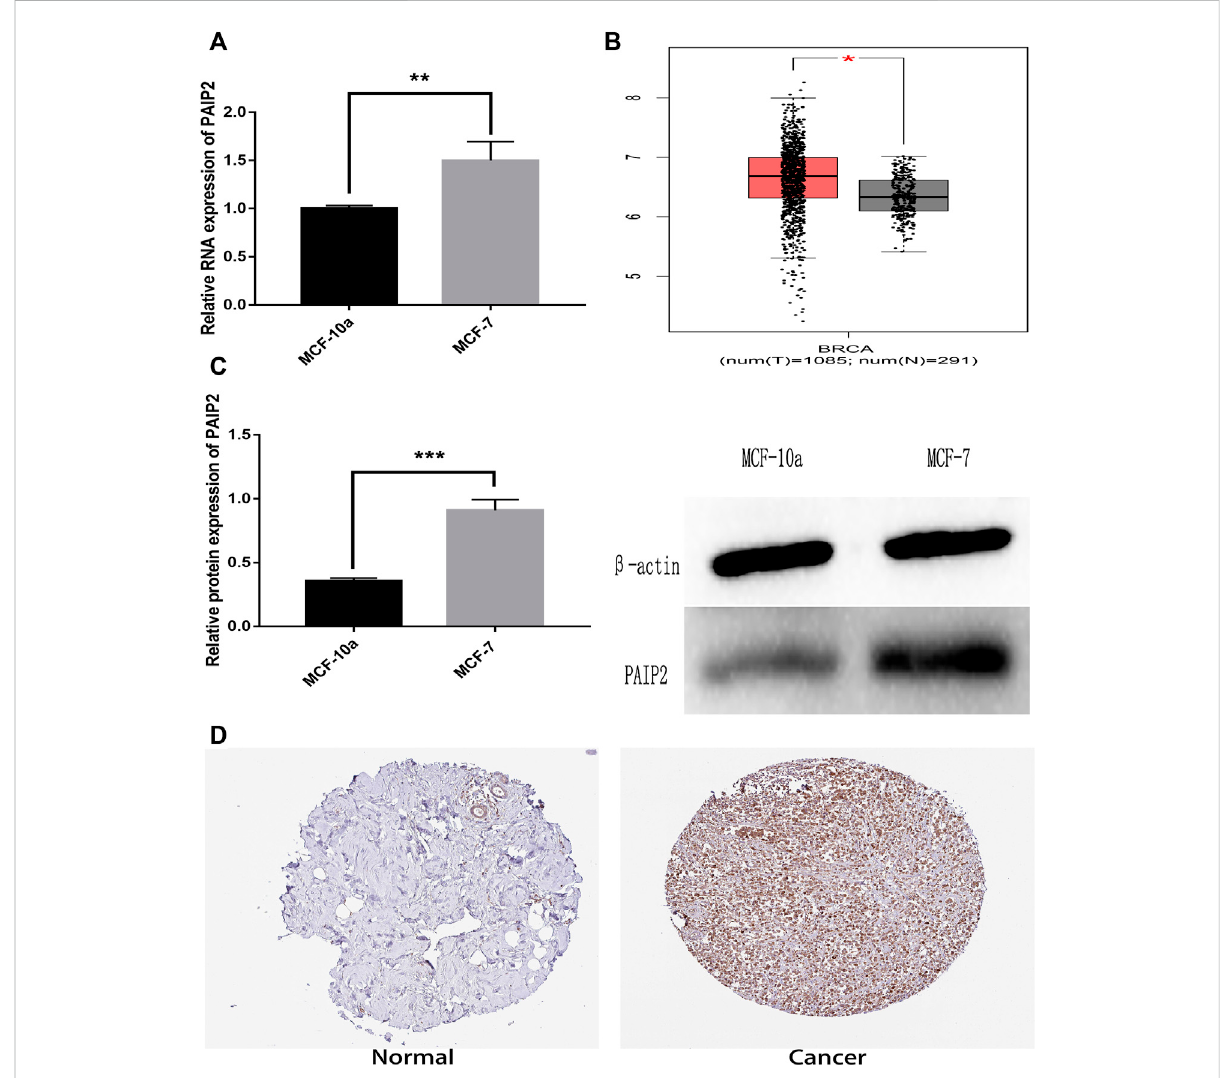
FIGURE 1 RelativeexpressionofPAIP2inbreastcancerspecimensandbreastcancercells. (A) :RT-qPCRshowedarelativelyhigherexpressionofPAIP2at mRNAlevelinbreastcancercells. (B) :ThePAIP2expressionofBRCAtissuesamplesinTCGAdatabasewashigherthanthatofbreastcanceradjacent tissues. (C) : Western Blot showed that the expression of the PAIP2 protein in breast cancer cells was higher than in breast cells. (D) : The expression level ofthePAIP2proteininbreastcancer tissues washigher than inadjacent tissuesfrom theimmunohistochemical imagesofPAIP2 obtained from the HPA database. (* represents p < 0.05, * * represents p < 0.01 and * * * represents p <